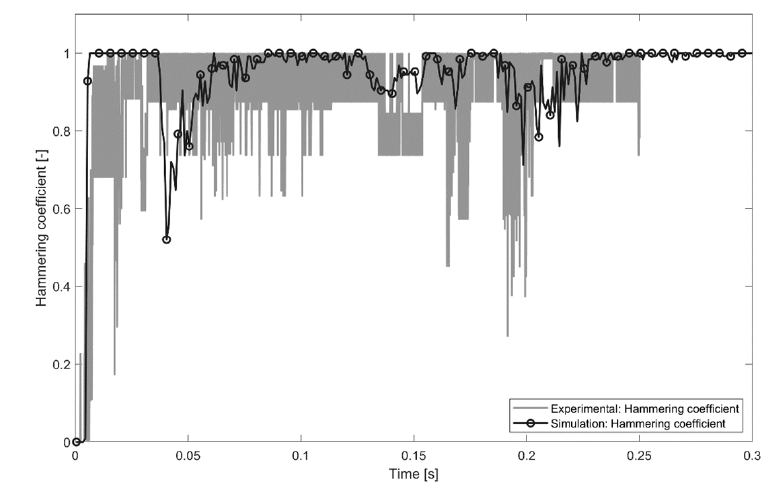
Figure 10. Hammering coefficient calculated on base of MATLAB point tracker and FEM.